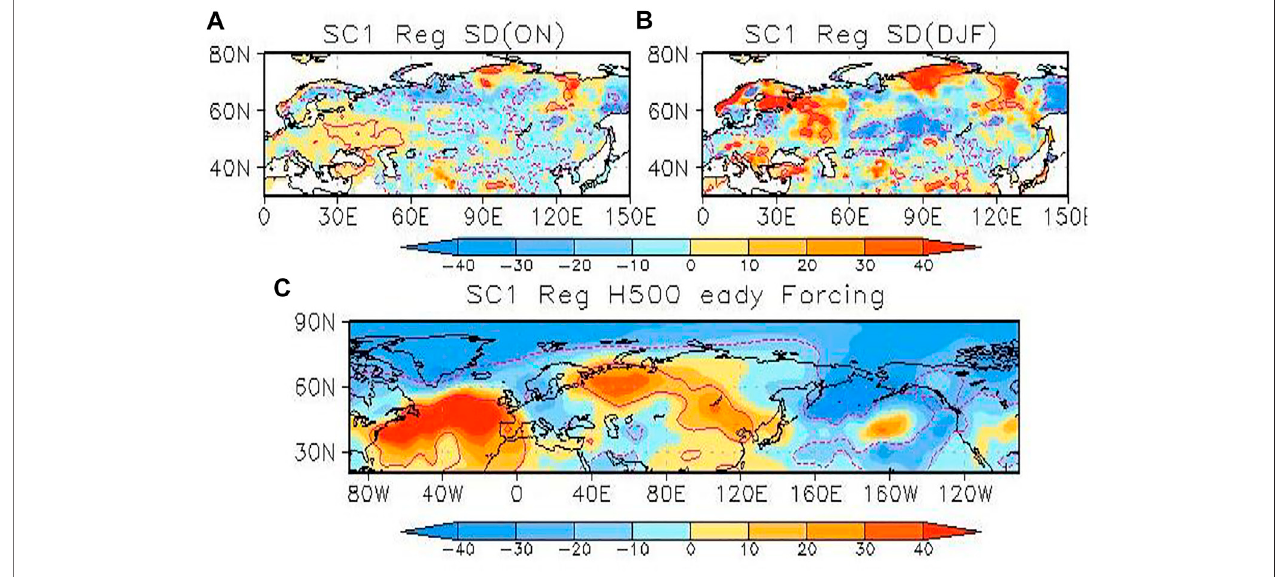
FIGURE 7 | Regressed anomalies of ON (A) , (B) DJF snow depth (shading, units: mm), and (C) H500 synoptic eddy-vorticity forcing onto expansion coef fi cient time series of snow cover in the fi rst SVD mode. The red line indicates the value signi fi cantly exceeding the 90% con fi dence level.